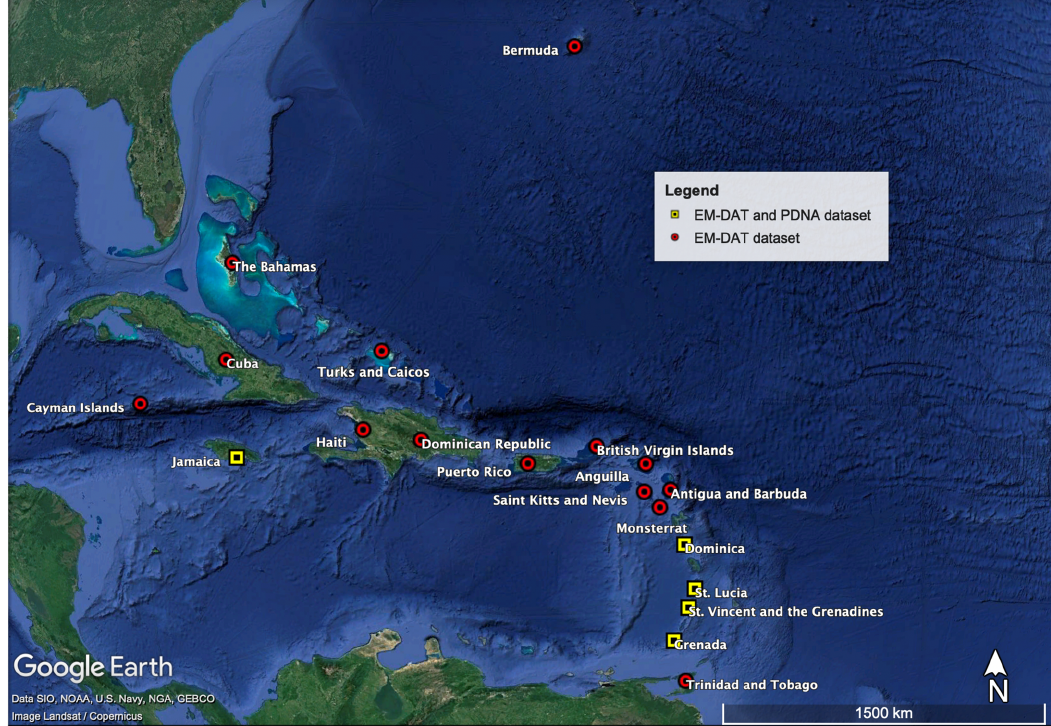
Figure 2. Map of Caribbean countries selected for the study.